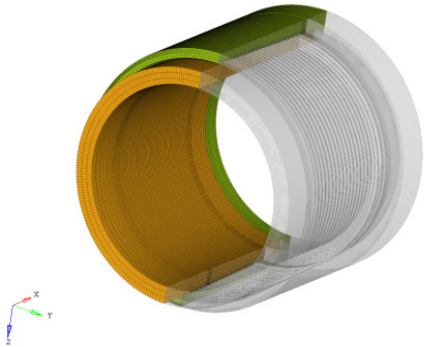
Figure 2. Three-dimensional finite element model of casing connection. Table 2. Geometric parameters of casing connection.